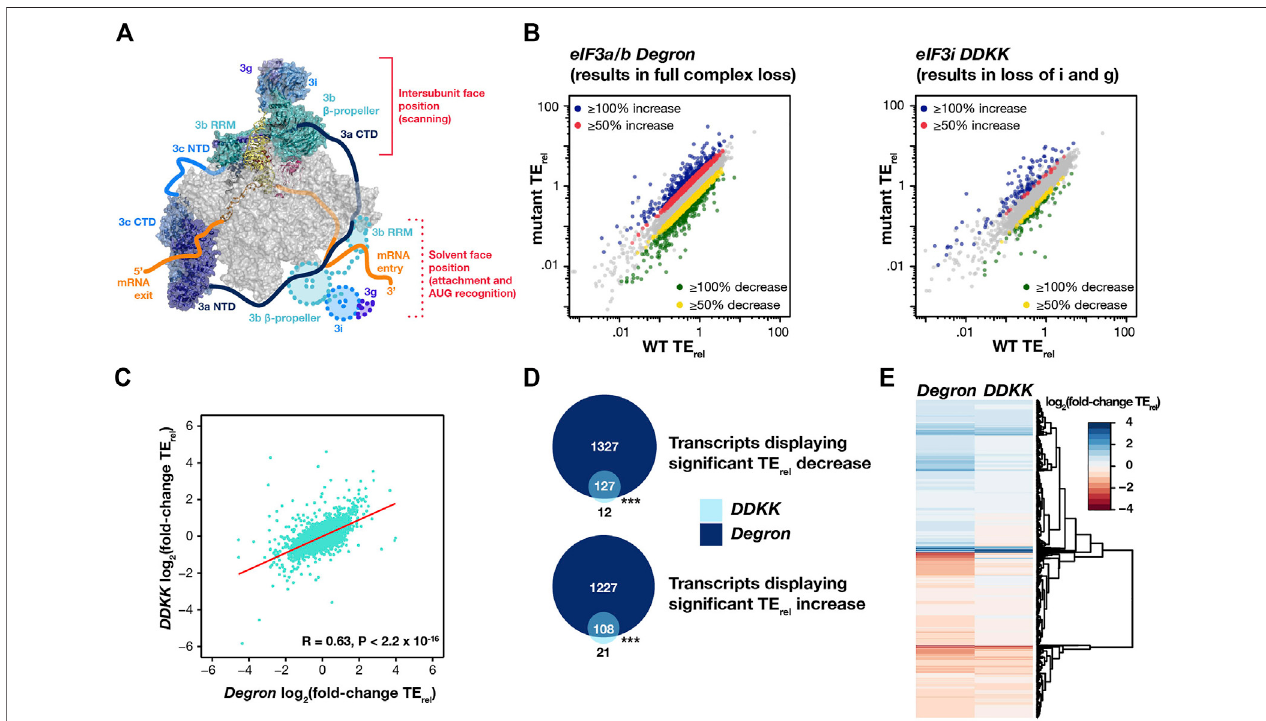
FIGURE 1 | Disruption of the eIF3 complex or its mRNA-entry channel arm provoke strong and overlapping effects on the translation of mRNAs across the transcriptome. (A) Structural model of eIF3 bound to the PIC (PDB 6GSM) viewed looking down at top of the small (40S) ribosomal subunit head so as to visualize the pathofmRNAasitentersandexitsthePIC(Lláceretal.,2021).Thesmall(40S)ribosomalsubunitisshowningrey,andtheinitiatortRNAandmRNAareshowninyellow andorange,respectively(withthepathofthemRNAenteringandexitingthePICshownasacartoon).SubunitsoftheeIF3complexareshowninbluesandgreens, with the mRNA-entry-channel arm shown in two positions: at the intersubunit face of the PIC (identi fi ed density seen in this structure) or at the solvent face (cartoons depicting approximate location observed in structures lacking mRNA or after start-codon recognition). (B) TE rel correlation plots comparing observed TE rel values in either eIF3a/b Degron (left) or eIF3i DDKK (right) cells with TE rel values observed in isogenic wild-type cells. Transcripts displaying signi fi cant (P adj < 0.05) TE rel increases ( ≥ 50% red and ≥ 100% blue) or decreases ( ≥ 50% yellow and ≥ 100% green) as determined by DESeq2 analysis are shown in color. (C) Correlation plot comparing observedTE rel changesin eIF3a/bDegron and eIF3iDDKK cells,withpredictedPearsoncorrelationshowninred. (D) Venndiagramsdescribingtheoverlapintranscripts displaying signi fi cant TE rel decreases (top) or increases (bottom) in eIF3a/b Degron (dark blue) or eIF3i DDKK (light blue) cells. *** (cid:1) P < 10 − 10 , ** (cid:1) P < 10 − 5 , * (cid:1) P < 0.05, HyperGeometric test. (E) Heatmap and dendrogram resulting from hierarchical clustering analysis of signi fi cant TE rel changes observed in eIF3a/b Degron and eIF3i DDKK cells.